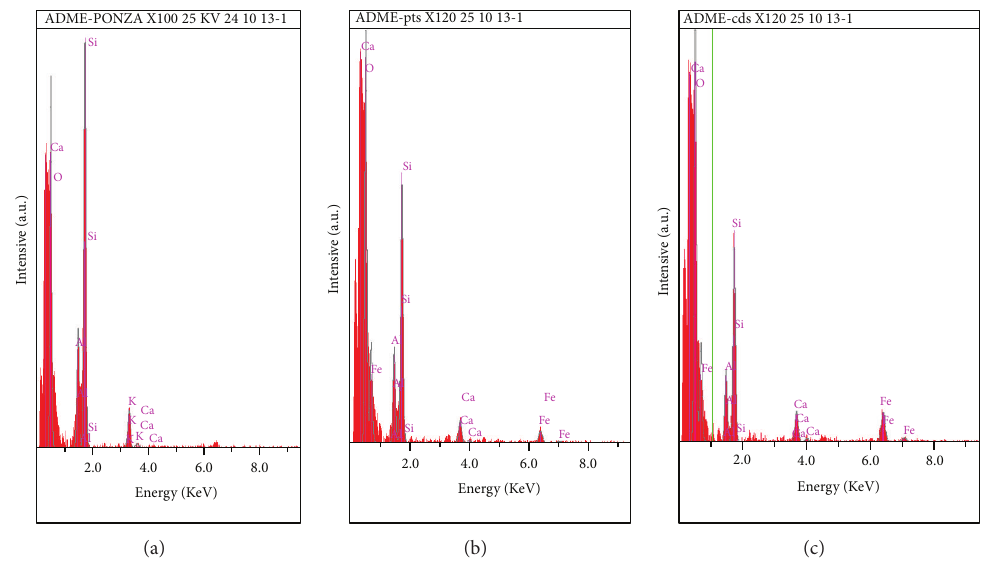
Figure 2: EDS analysis: (a) pumice, (b) PTS, and (c)